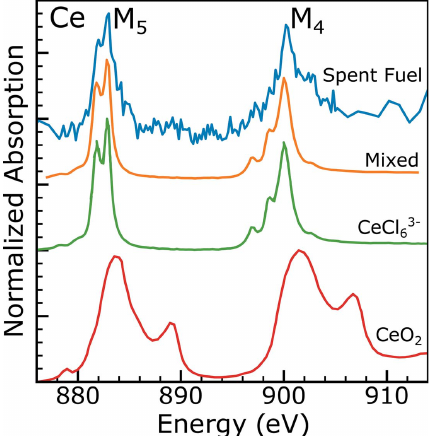
Figure 10 Cerium M 4,5 -edge spectra for the spent fuel FIB section 2B (blue) sourced from the edge of the sample, trivalent CeCl 63 (cid:2) (green) and tetravalent CeO 2 (red). Trivalent and tetravalent reference spectra are taken from Smiles et al. (2020). Also shown is a mixed reference (orange), generated by a linear combination of 80% CeCl 63 (cid:2) and 20% CeO 2